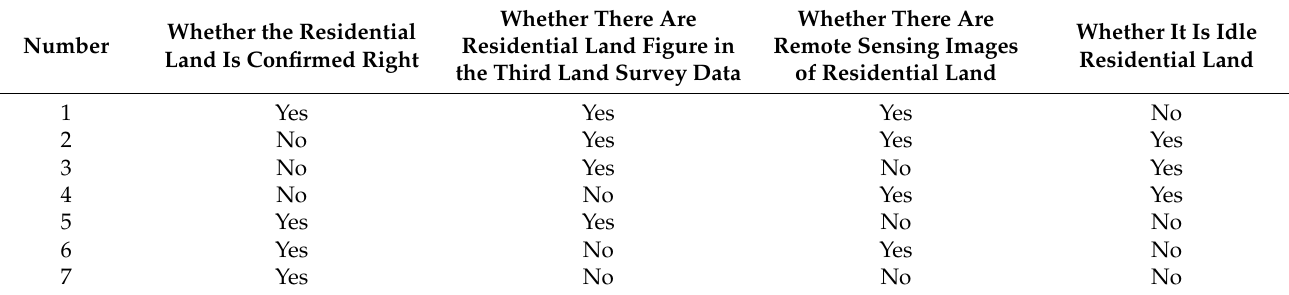
Table 1. Identification matrix of the idle residential